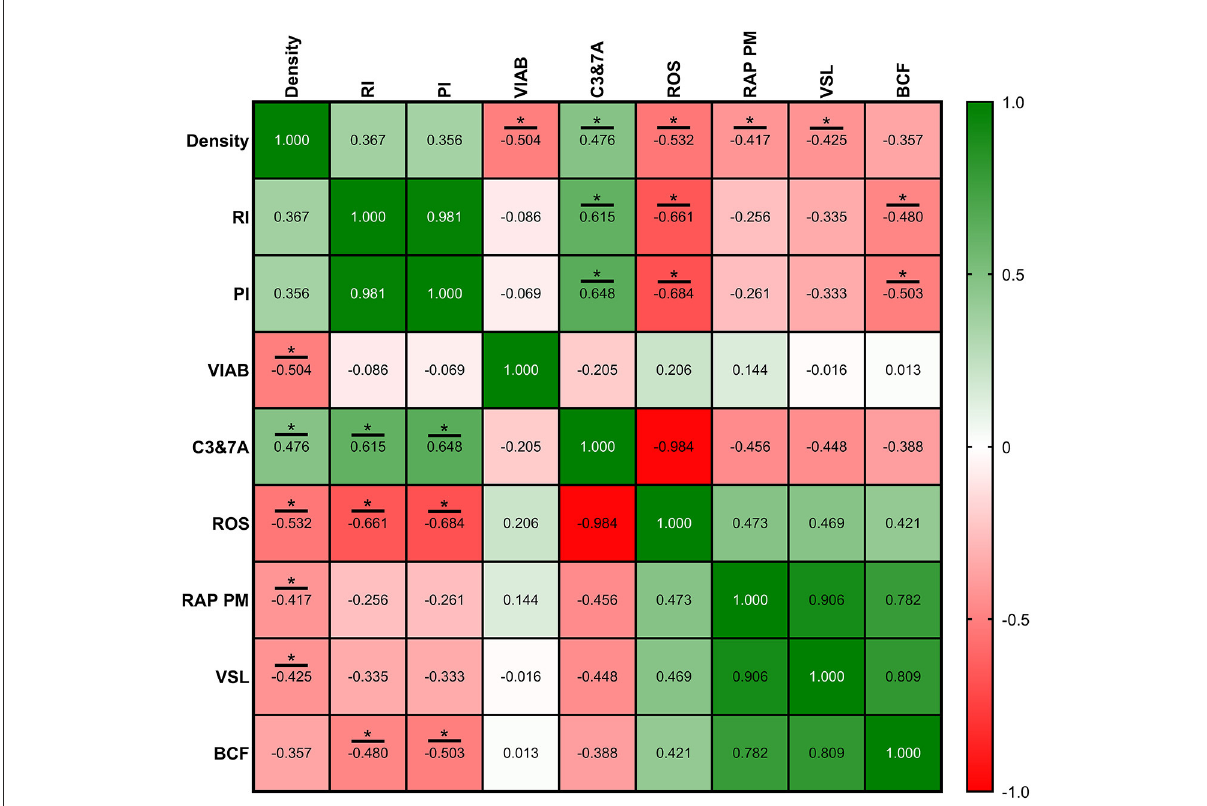
FIGURE10 Correlation coefficients between ultrasonography measurements and sperm quality parameters in intensive semen collection frequency (IF). Sperm quality parameters used were measured on Friday (corresponding with IRF). Density, density of hypoechogenic areas per cm 2 corresponding with the seminiferous tubules; RI, resistive index; PI, pulsatility index; VIAB, viability (%); C3&7A, caspases 3 and 7 activity (%); ROS, ROS content (%); RAP PM, rapid progressive motility (%); VSL, straight-line velocity ( µ m/s); BCF, beat frequency (Hz). The same 25 males were analyzed in each parameter. The R squared value between two parameters is represented in each cell and graph. In the correlation matrix, green color indicates positive correlations, and red color indicates negative relationships. The color intensity represents the strength of the correlation between two parameters. Asterisks show significant correlations ( P ≤ 0.05) between ultrasonography measurements and sperm quality